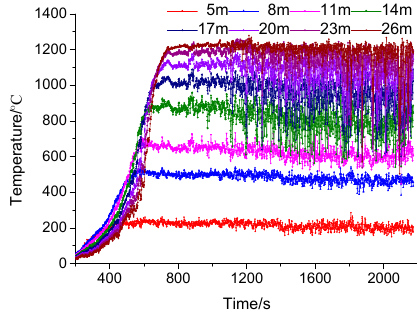
Figure 10. Surface temperatures of building’s exterior. Int. J. Environ. Res. Public Health 2016 , 13 , 861